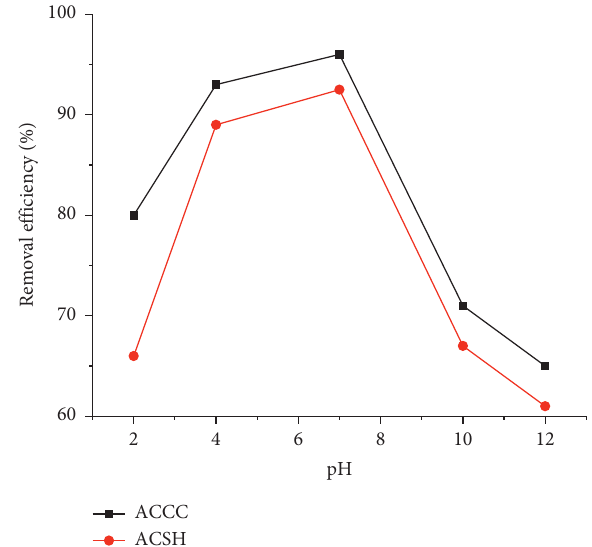
Figure 5: Effect of pH on fluoride removal efficiency of activated carbon of corncob, and sorghum husk (dose � 6 g contact time � 1 h) with an initial fluoride concentration of 5.0 mg/L.